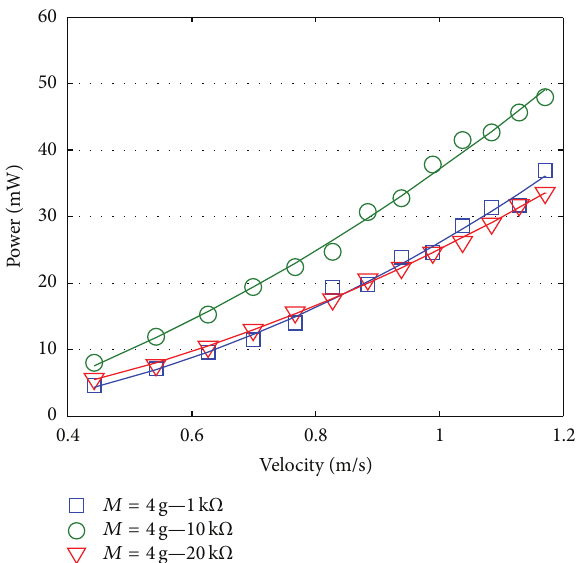
Figure 6: Average output power (2 ms) versus momentum plots for 4 g and 8g steel balls.